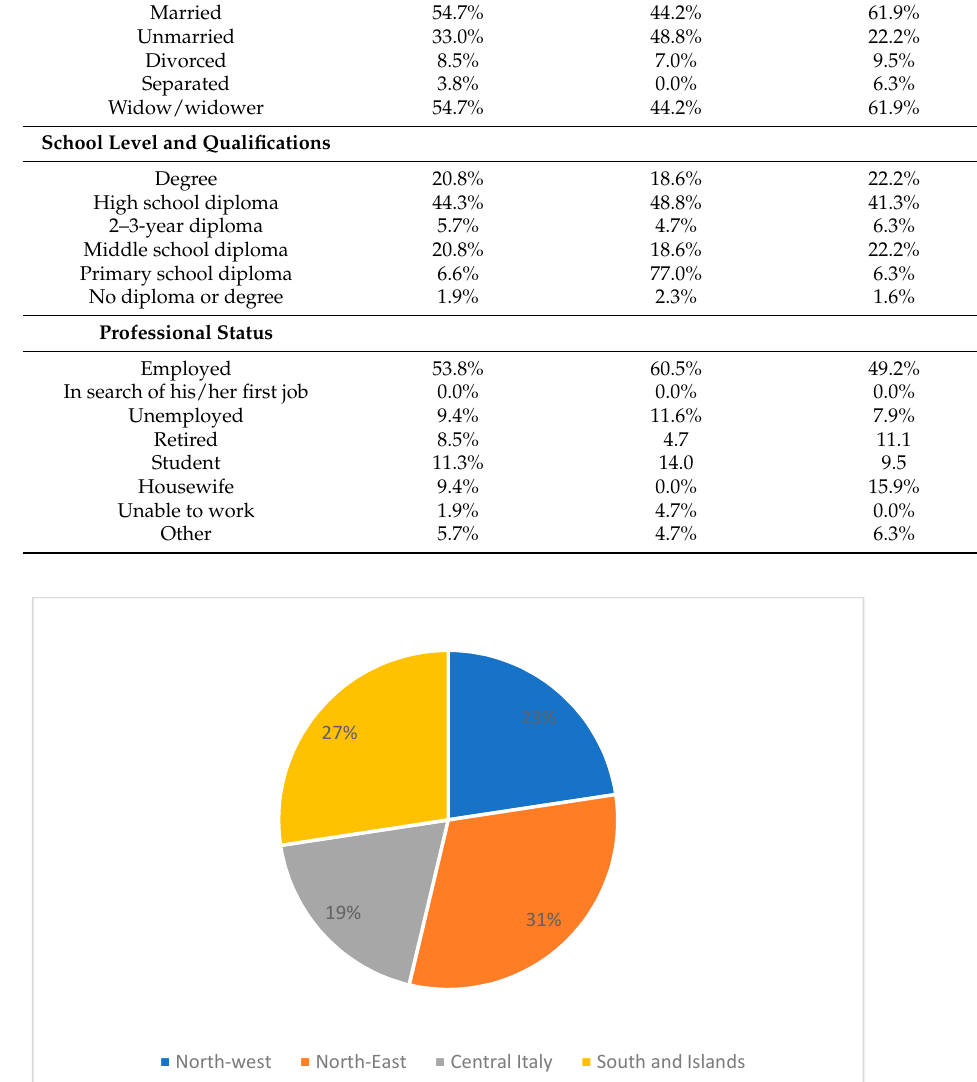
Figure 1. Geographical distribution of Italian patients with Fabry disease in our study. 114 As for the schooling rate, 14.0% of the sample had a specific degree, 34.3% achieved 115 a high school diploma, 44.4% had a middle or elementary school diploma, and only 1.7% 116 did not have any school qualifications. The majority of FD patients (82.1%) received Fabry ‐ 117 specific treatment: in particular, 74.5% were on ERT, 7.6% were taking oral therapy, 118 whereas 17.9% did not take any treatment.